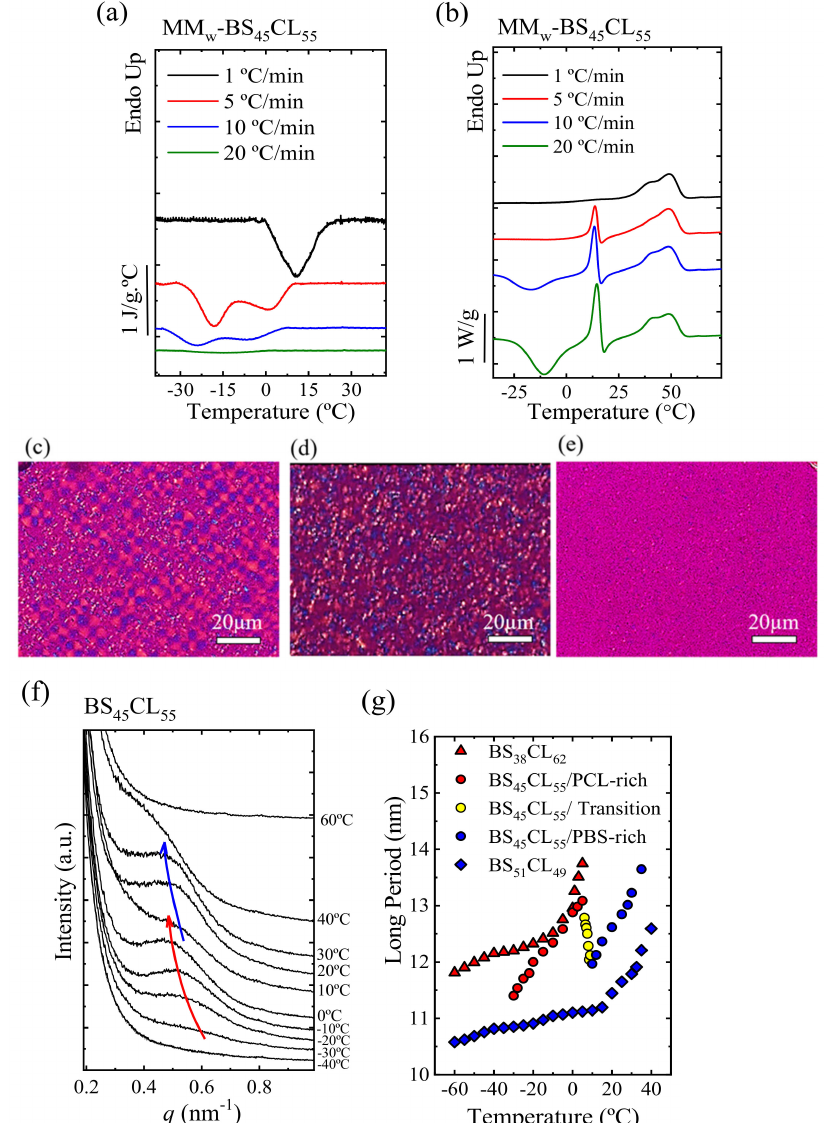
Figure 8. For MM W -BS 45 CL 55 sample (the sample at the pseudo-eutectic point): ( a ) cooling runs from the melt to − 60 ◦ C at different cooling rates, ( b ) subsequent heating scans at 20 ◦ C/min. ( c ) PLOM micrographs taken after non-isothermal crystallization at different cooling rates: 5 ◦ C/min, ( d ) 10 ◦ C/min and ( e ) 20 ◦ C/min. ( f ) SAXS patterns registered during heating at 10 ◦ C/min. ( g ) Long period values extracted from the SAXS maxima during cooling for compositions close to and at the pseudo-eutectic point. Reprinted with permission from ref. [37]. Copyright 2018 American Chemical